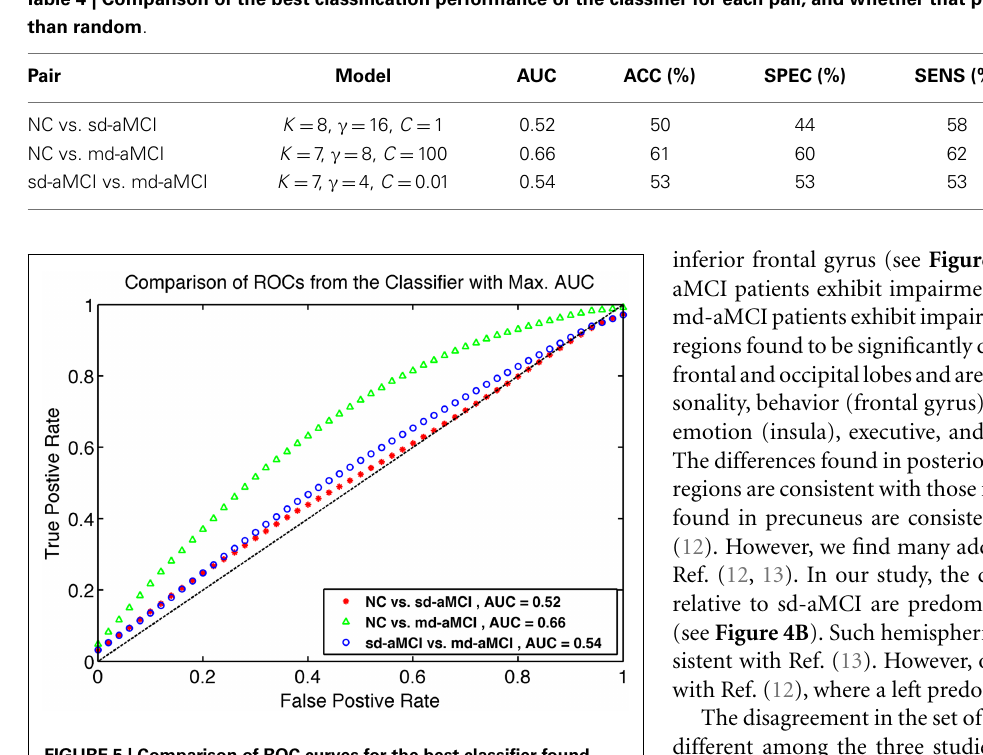
FIGURE 5 | Comparison of ROC curves for the best classifier found from grid search as described in Section 2.6 .The model from which ROC is generated are listed in Table 4